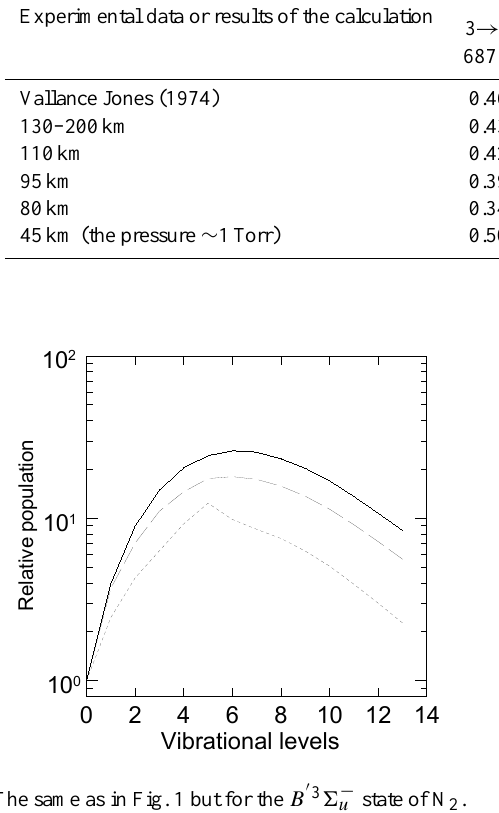
Fig. 3. The same as in Fig. 1 but for the B Figure 3. The same as in Fig.1 but for the B' 3 Σ u– state of N 2 .